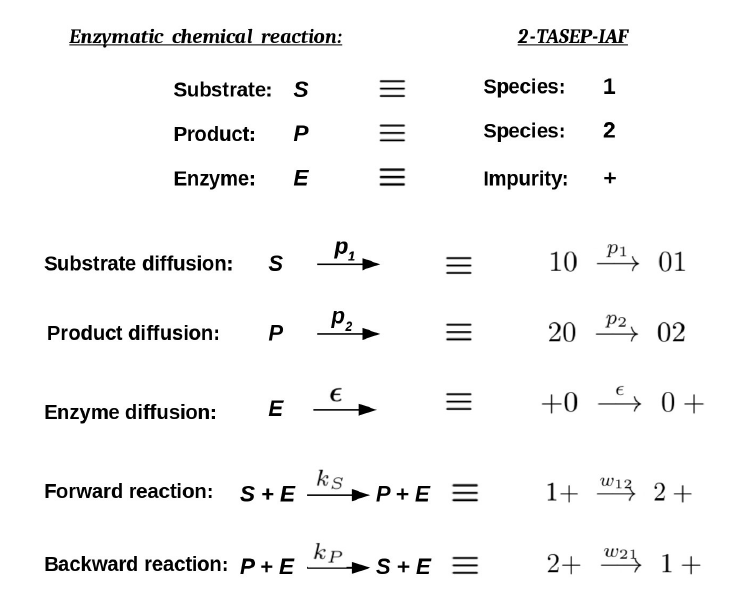
Figure 15: The figure illustrates the connection between the simplified form of the enzymatic chemical reaction Eq. (C.2 ) (in a narrow channel with many units of drifting enzymes, substrates and products) and the 2-TASEP-IAF. The enzyme, sub- strate and product in the chemical system can be identified as impurity, species 1 and species 2 particle in the